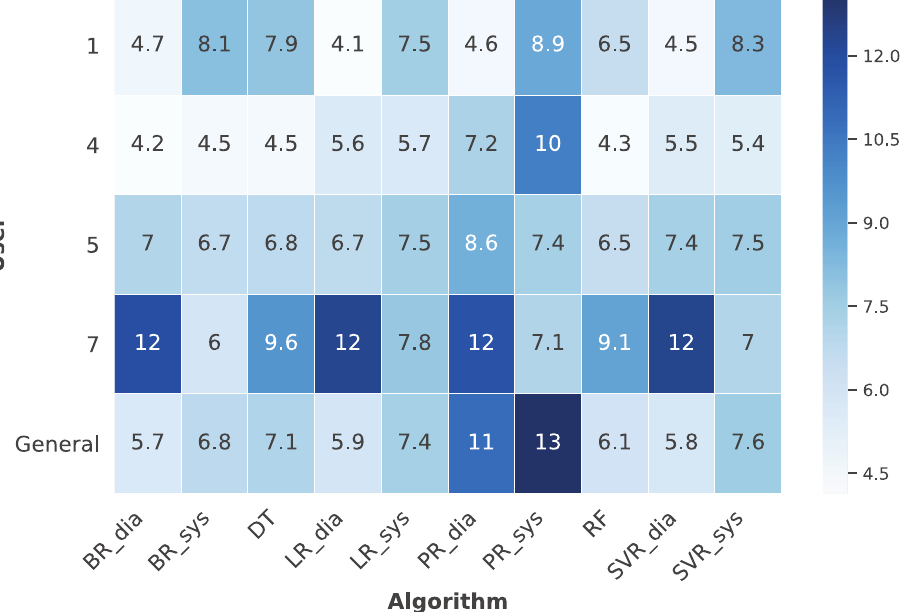
Figure 12. Heatmap indicating the RMSE error for each trained